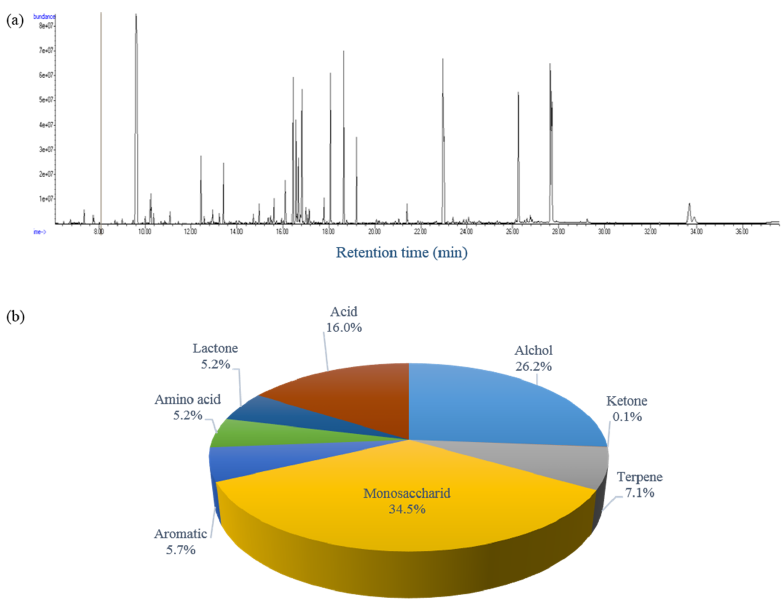
Figure 3. ( a ) Typical total ion chromatogram and ( b ) relative contents (%) of chemical classes of Xanthii Fructus samples obtained by gas chromatography time-of-flight mass spectrometry (GC-TOF MS).